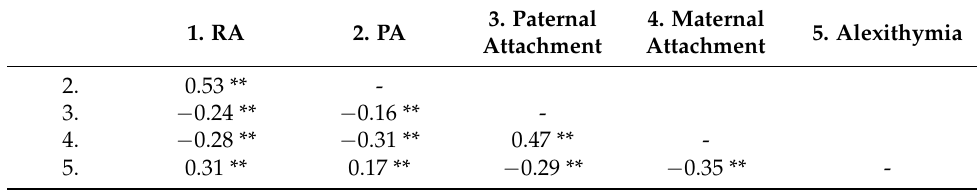
Table 3. Spearman’s rho